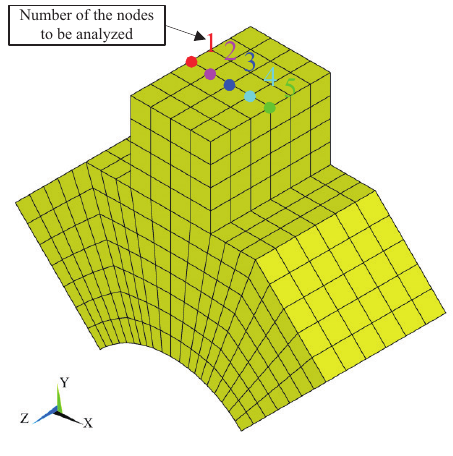
Figure 24. Distribution of the five analyzed nodes at the contact interface.